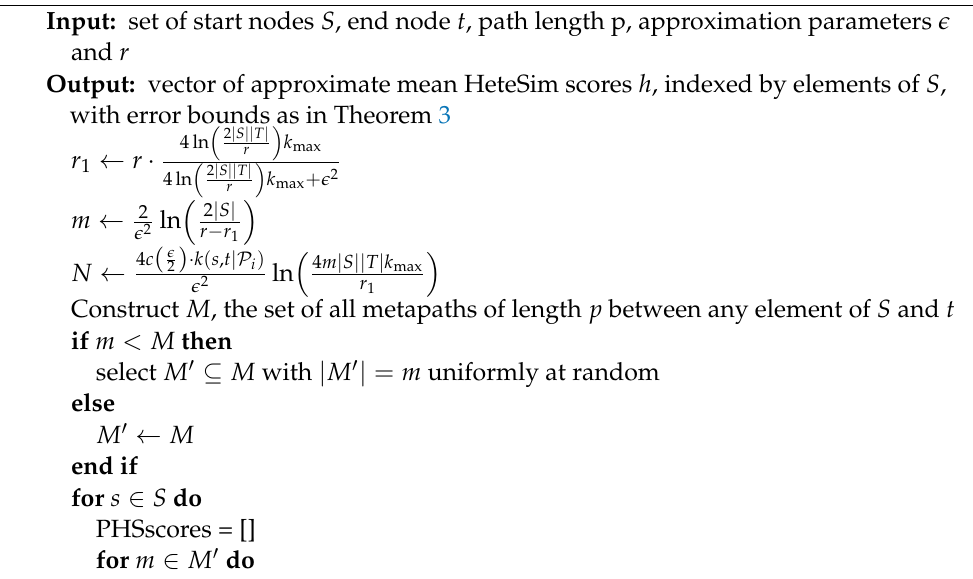
Algorithm 8: Approximate Mean Pruned HeteSim score.